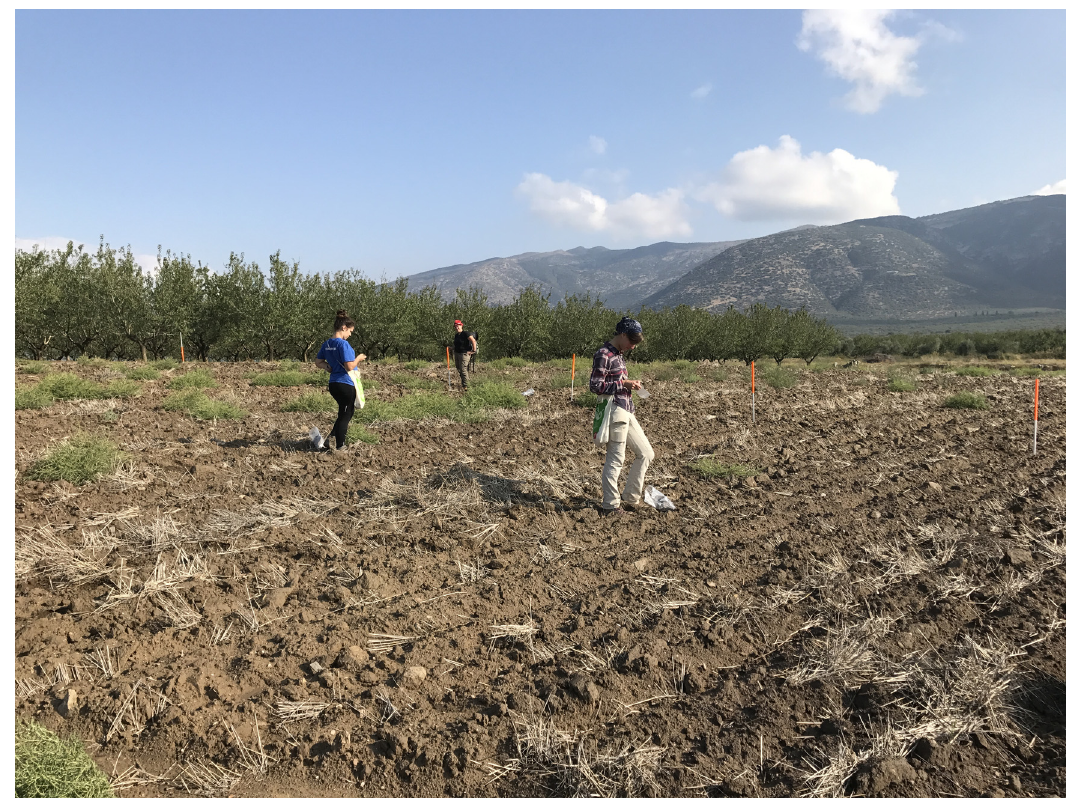
Figure 7: The fl at site of Elateia - Bigmeni Petra under intensive survey in September 2017 ( Agathe Reingruber )